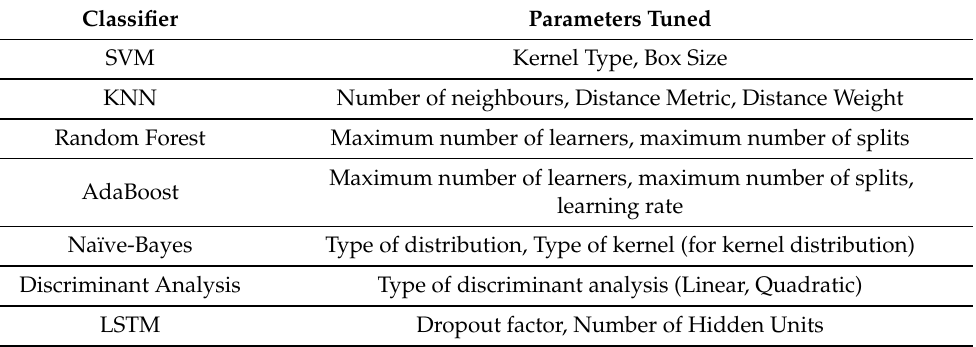
Table 2. Parameters tuned in Experiment